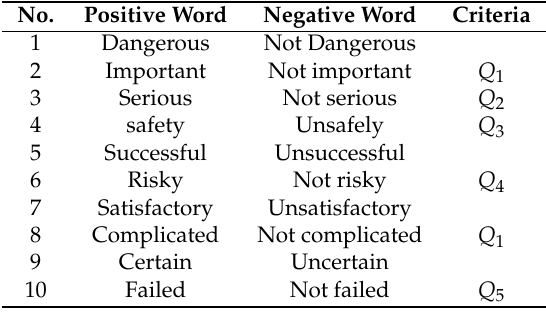
Table 1. Adjectives— Kansei words in Kansei evaluation.